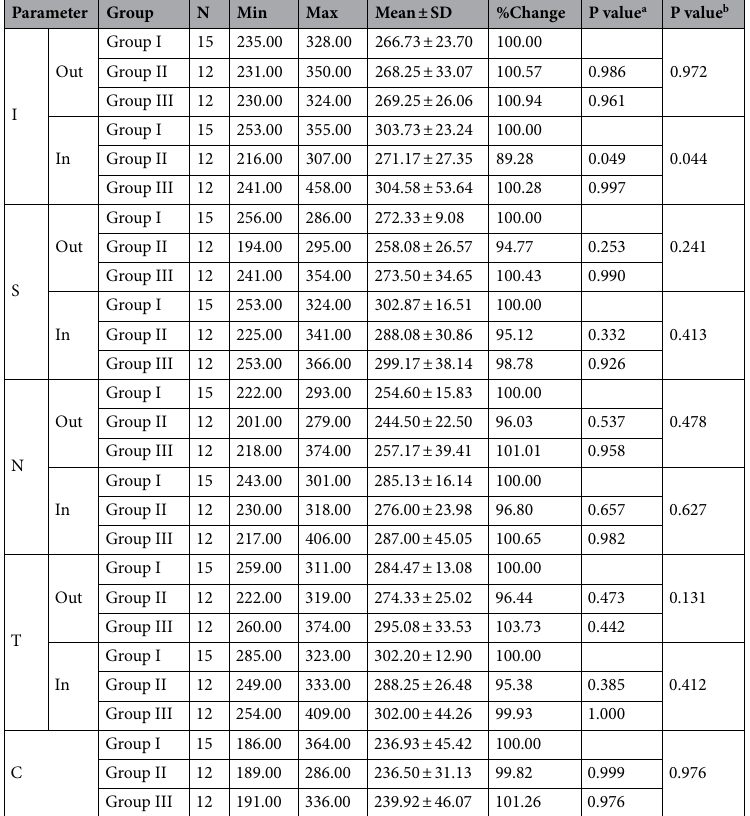
Table 3. Outer and inner macular thickness (µm) in four quadrants of left eye (OS) of controlled diabetic patients with and without retinopathy compared to healthy control subject. Comparisons done using one- way ANOVA test between all groups with multiple comparisons (Dunnett test) to compare each group with the control group in all parameters. a P value between each group and the control group. b P value between all